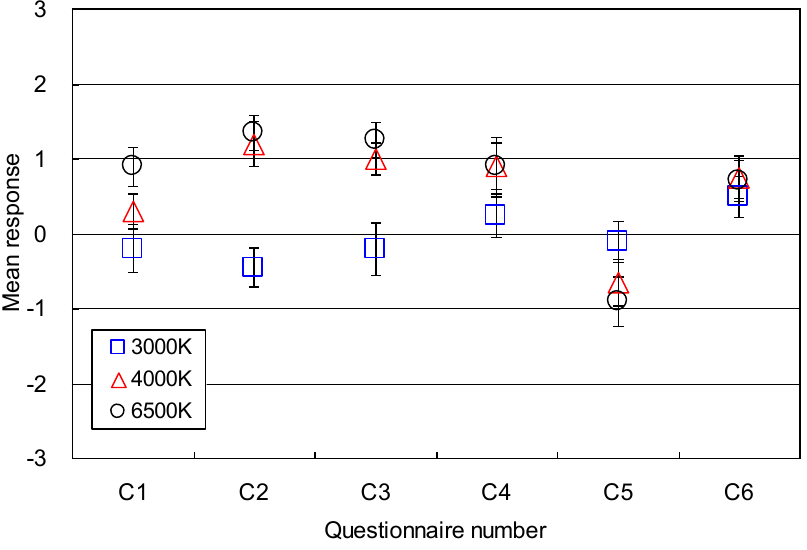
Figure 12. Visual comfort and annoyance (500 lx, Computer task).